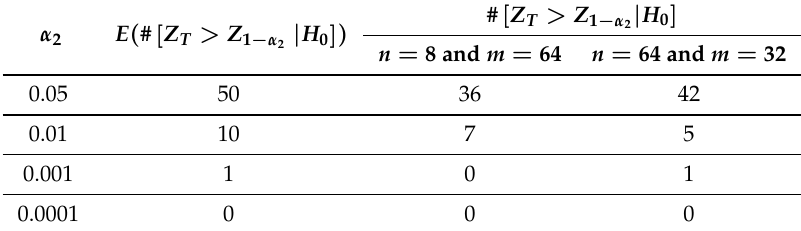
Table 8. Expected E ( # [ Z T > Z 1 − α samples of 1000 values of Z t for n (cid:54) = m , in H i random matrices.